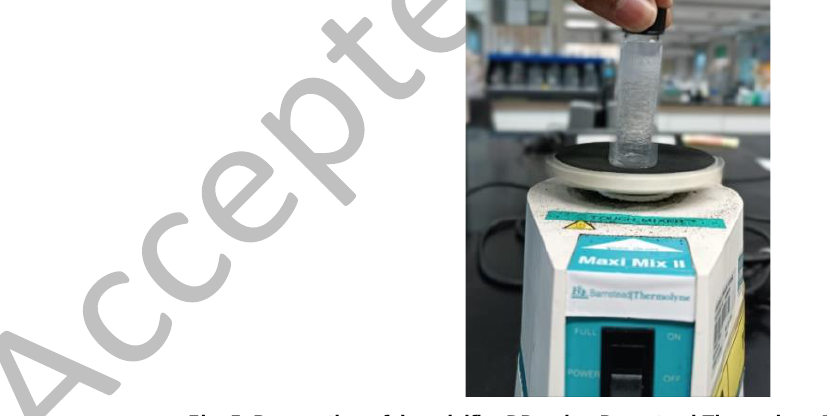
Fig. 5- Preparation of demulsifier DB using Barnstead Thermolyne Maxi Mix II Vortex